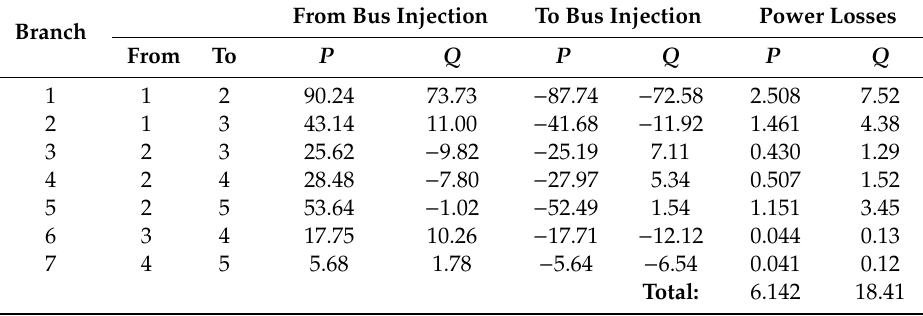
Table A23. Results of the mixed AC / DC PF calculations in Case 6-1. AC branch data.